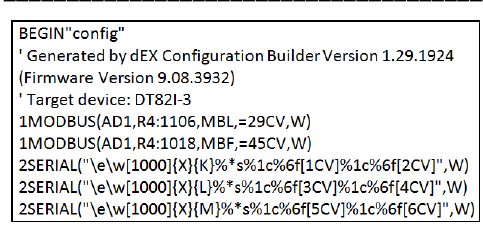
Fig. 7. The digital sensor data acquisition program.